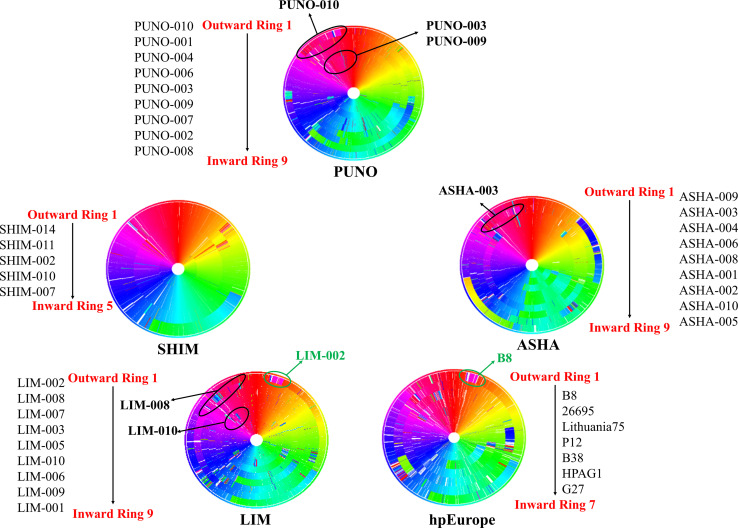
Genomic consensus of the study populations and hpEurope references. These circular views were obtained using the method developed by Tada et al. (2017), which creates a consensus genome that is used as a template for alignment. Each ring represents one complete genome and each block in the ring represents a genomic region. Different colors represent the genes according to their genomic position in the consensus. The shifts in the color represent the rearrangements. The outermost ring is the distant genome from the consensus. The names alongside each circle indicate the genomes going from outward to inward direction. The indicated areas (black circles) in the ASHA (ring 2) and PUNO (rings 1, 5, and 6) genomes show the regions in which these genomes are similar to the LIM (rings 2 and 6). The green circles indicate the similarities between the LIM genomes and the hpEurope references. The genomes ASHA-003, PUNO-003, PUNO-009, and PUNO-010 had an inversion from 10 o’clock to 11 o’clock which was not observed in SHIM genomes.